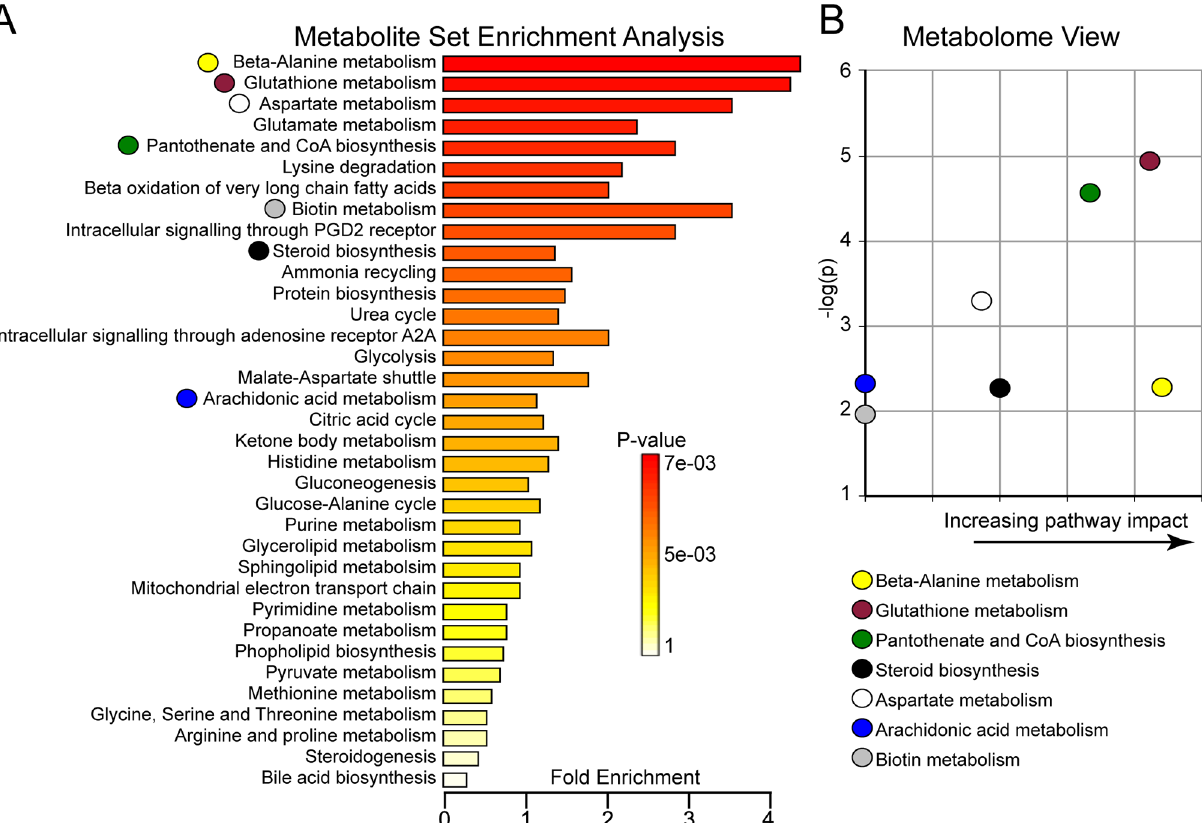
Fig 3. Metabolite pathway affected by aging. (A) Summary plot for the metabolite set enrichment analysis (MSEA) are ranked by Holm p-value. Holm p- value is the p value adjusted by Holm-Bonferroni test that is a method to counteract the problem of multiple comparisons and is widely used for large-scale data analysis. (B) Metabolome view shows key nodes in metabolic pathways that have been significantly altered with aging. The y-axis represents unadjusted p value from pathway enrichment analysis. The x-axis represents increasing metabolic pathway impact according to the betweenness centrality from pathway topology